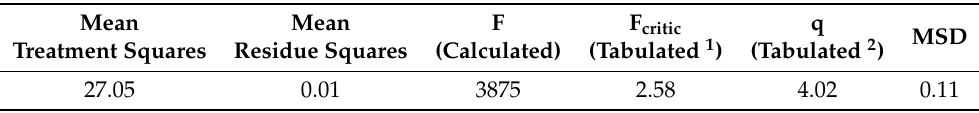
Table 10. ANOVA and Tukey’s test parameters for the shear modulus.